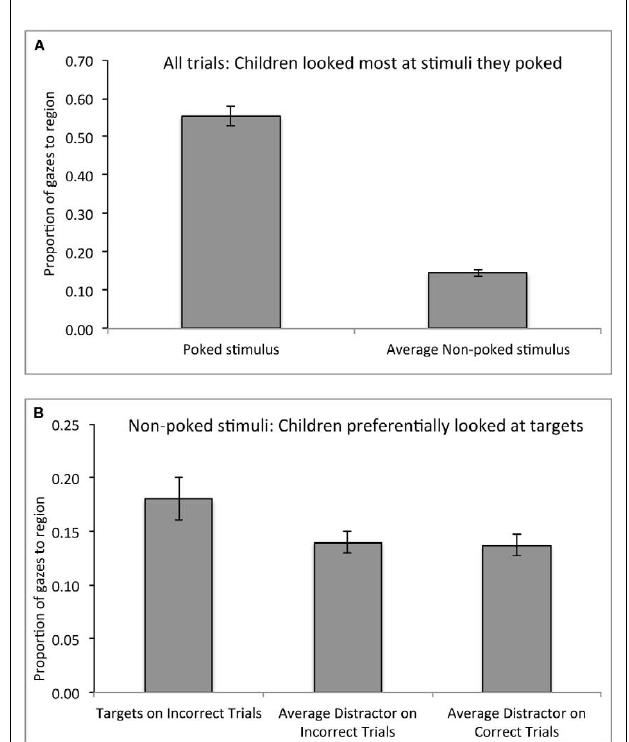
FIGURE 5 | Eye-gaze data on the orientation odd-one-out task. (A) Unsurprisingly, children looked most at the items they pointed to in each trial, regardless of accuracy. (B) Critically, even when children poked the wrong stimulus, they looked more at the target than at both the average non-poked distractor on those incorrect trials and the average distractor on the correct trials, indicating some sensitivity to the correct answer. Switchers and perseverators did not differ in this pattern, suggesting that visually detecting these targets is independent of cognitive flexibility.The proportions do not add to 1.0 because gazes to Non-reached stimuli and Distractors were computed as averages (i.e., as the total number of gazes to all of the candidate stimuli divided by the number of stimuli), for comparison to the single Reached or singleTarget stimulus. Error bars represent